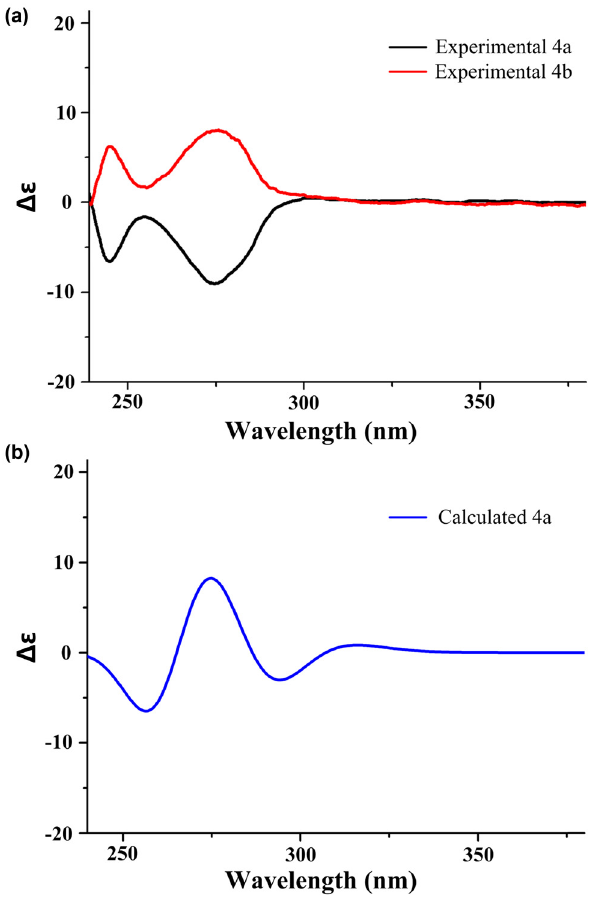
Figure 3: ( a ) Experimental ECD spectra of 4a ( black line ) and 4b ( red line ) in MeOH and ( b ) calculated ECD spectra of 4a ( blue line ) at the TD - B3LYP/6 - 31G ( d ) //B3LYP/6 - 31G ( d )